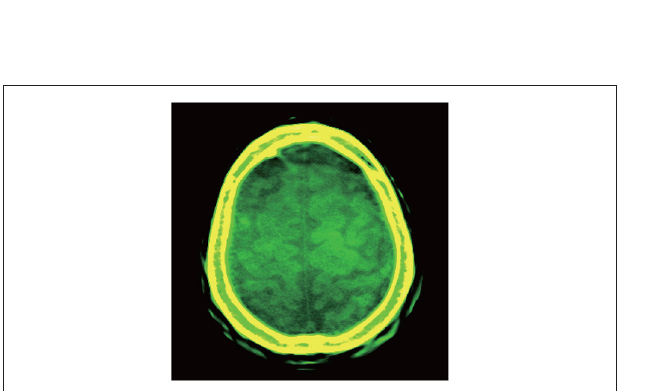
FIGURE 3 | Color image overlaid by the attenuation coefficients at monochromatic 40, 50, and 100 keV, with the display window [ − 150, 210] (Unit: HU) of the components at each keV.